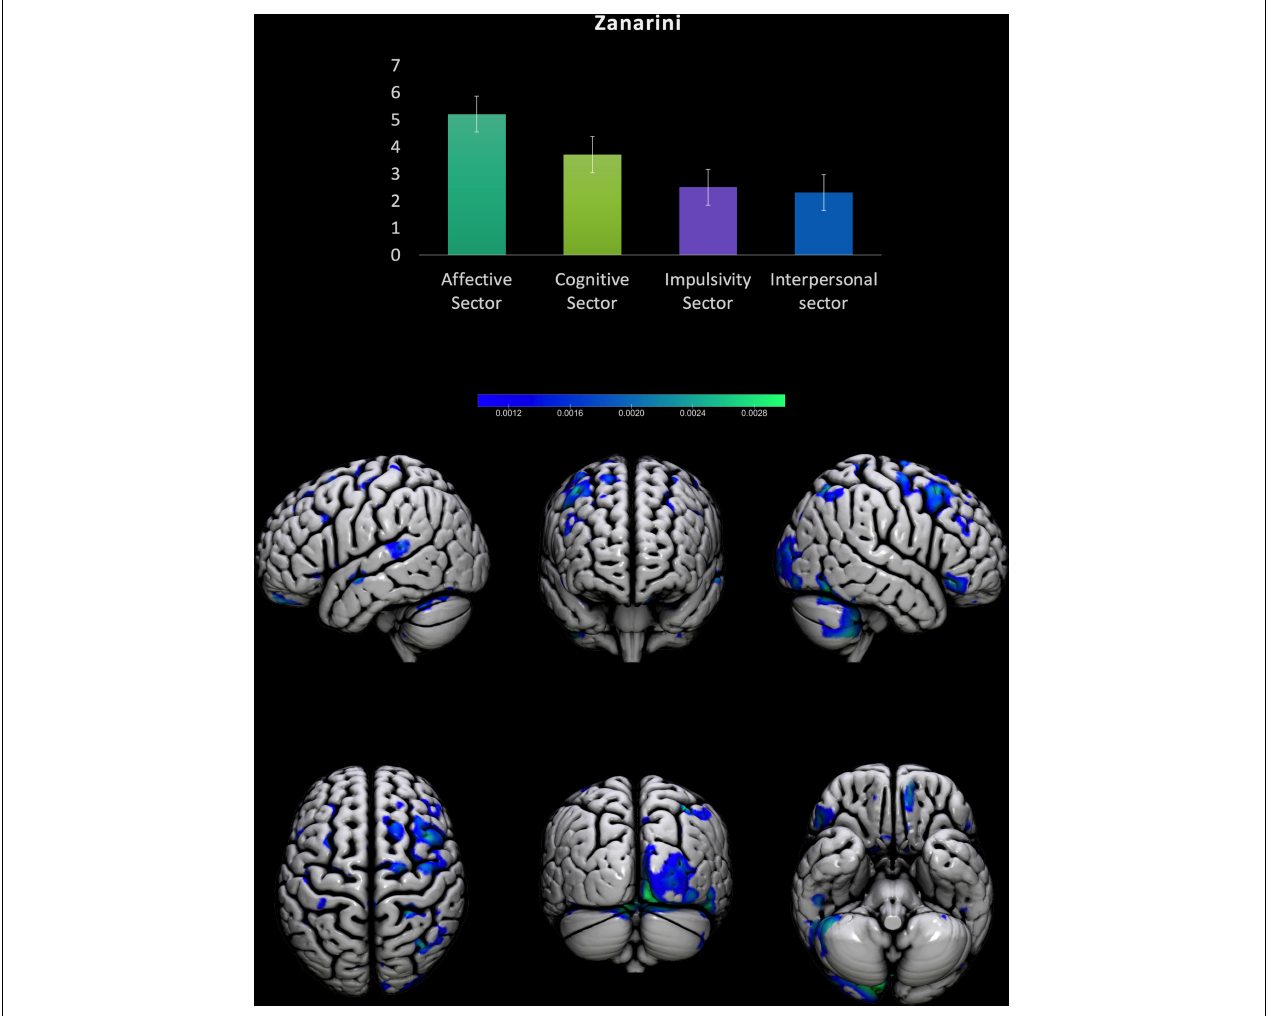
FIGURE 2 | Results from the prediction of Zanarini scales for BPD patients. Upper part, results from the Zanarini sectors scores for BPD patients. Lower part, surface plots of the significant regions predicting Interpersonal problems subscale in BPD